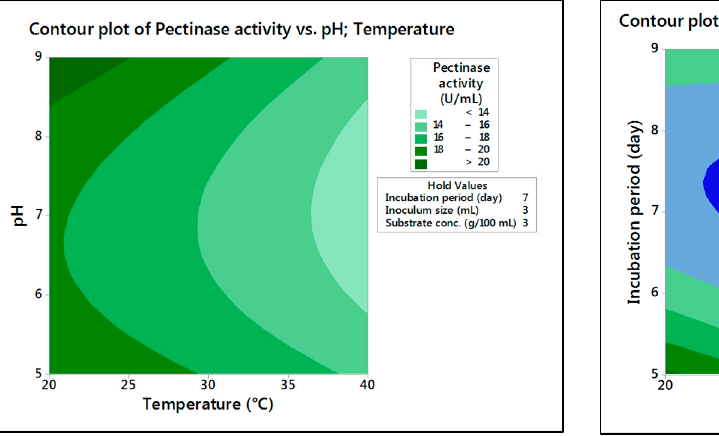
Figure 4. Contour plot showing interactions between independent variables: ( a ) incubation tem- perature with pH; ( b ) incubation temperature with incubation period; ( c ) incubation temperature with inoculum size; ( d ) incubation temperature with substrate concentration; ( e ) pH with incubation period; ( f ) pH with inoculum size; ( g ) pH with substrate concentration; ( h ) incubation period with inoculum size; ( i ) incubation period with substrate concentration; ( j ) inoculum size with substrate concentration for cellulase activity produced by M. hiemalis .